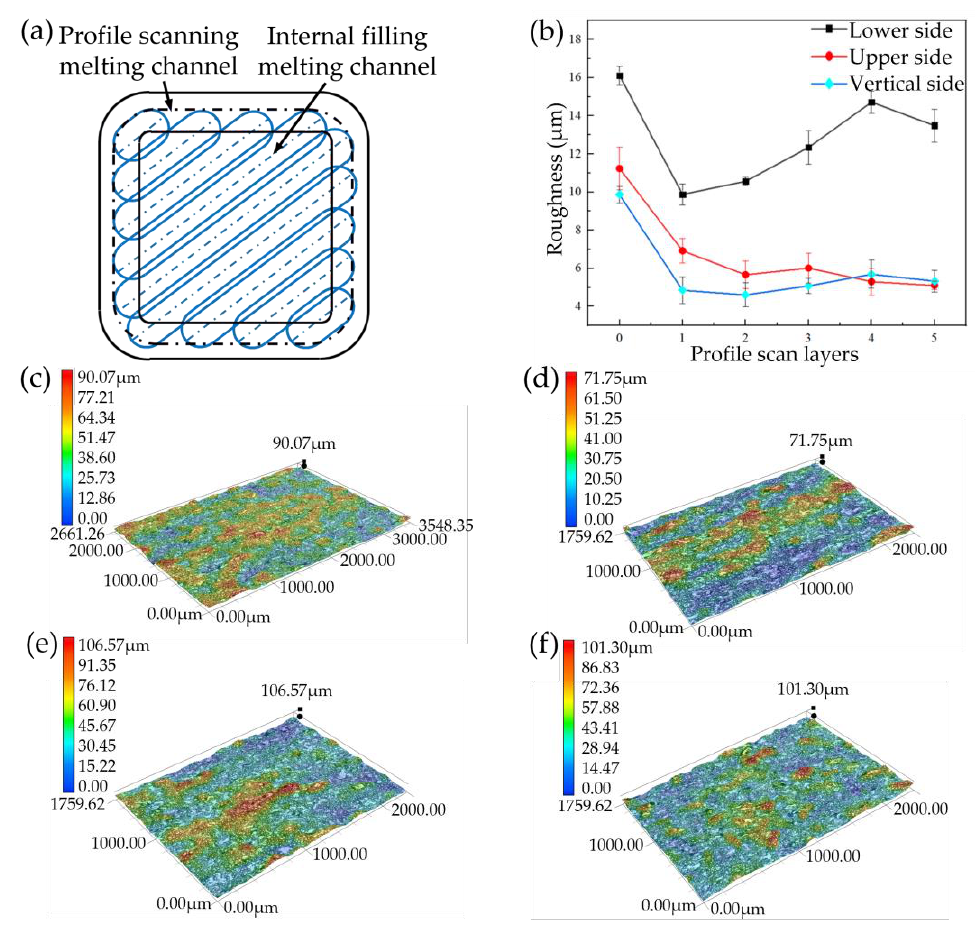
Figure 15. Changes in surface topography and roughness under different profile scanning layers: ( a ) schematic diagram of profile scanning; ( b ) roughness changes; ( c ) lower side of 0 layer; ( d ) lower side of 1 layer; ( e ) lower side of 4 layer; ( f ) lower side of 5 layer.